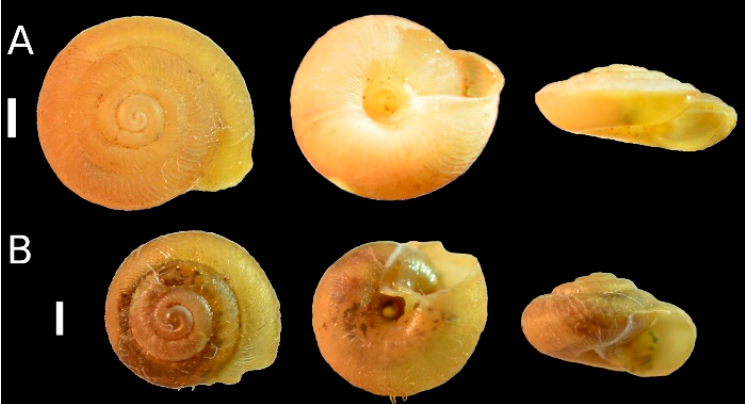
Figure 3. ( A ) Caracollina lenticula (Michaud, 1831), ( B ) Xerotricha conspurcata (Draparnaud, 1801). Scales bars correspond to 1 mm.